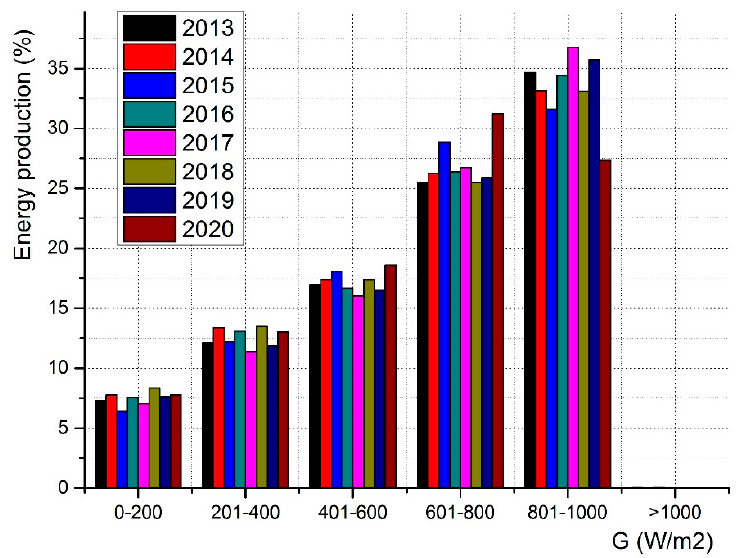
Figure 3. Percentage of energy production in the various irradiance classes during the 8-year period.